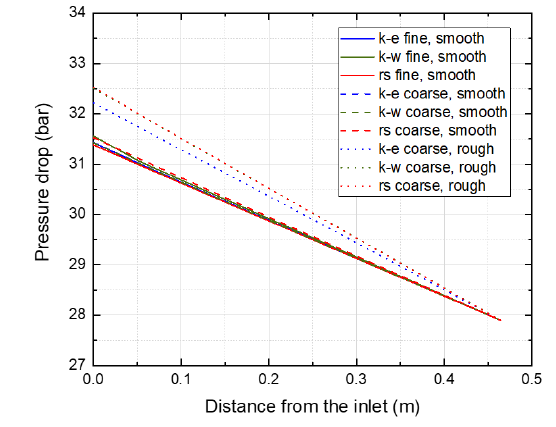
Figure 5: The pressure drop in the channel for all the performed